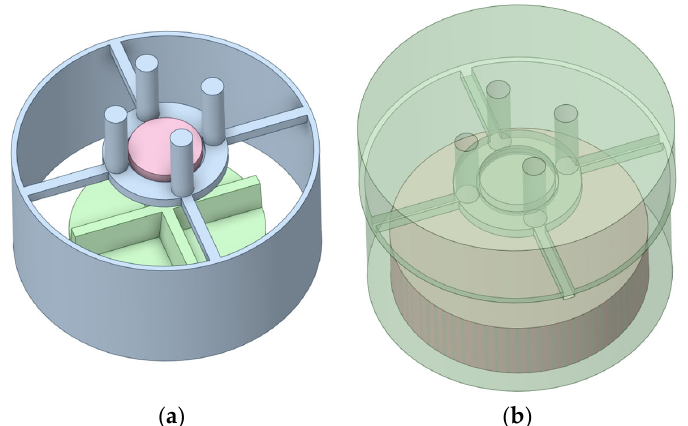
Figure 2. Geometry of the beaker and stirrer system and the fluid domain with stirrer 1 ( a ) solid bodies; ( b ) fluid domain.